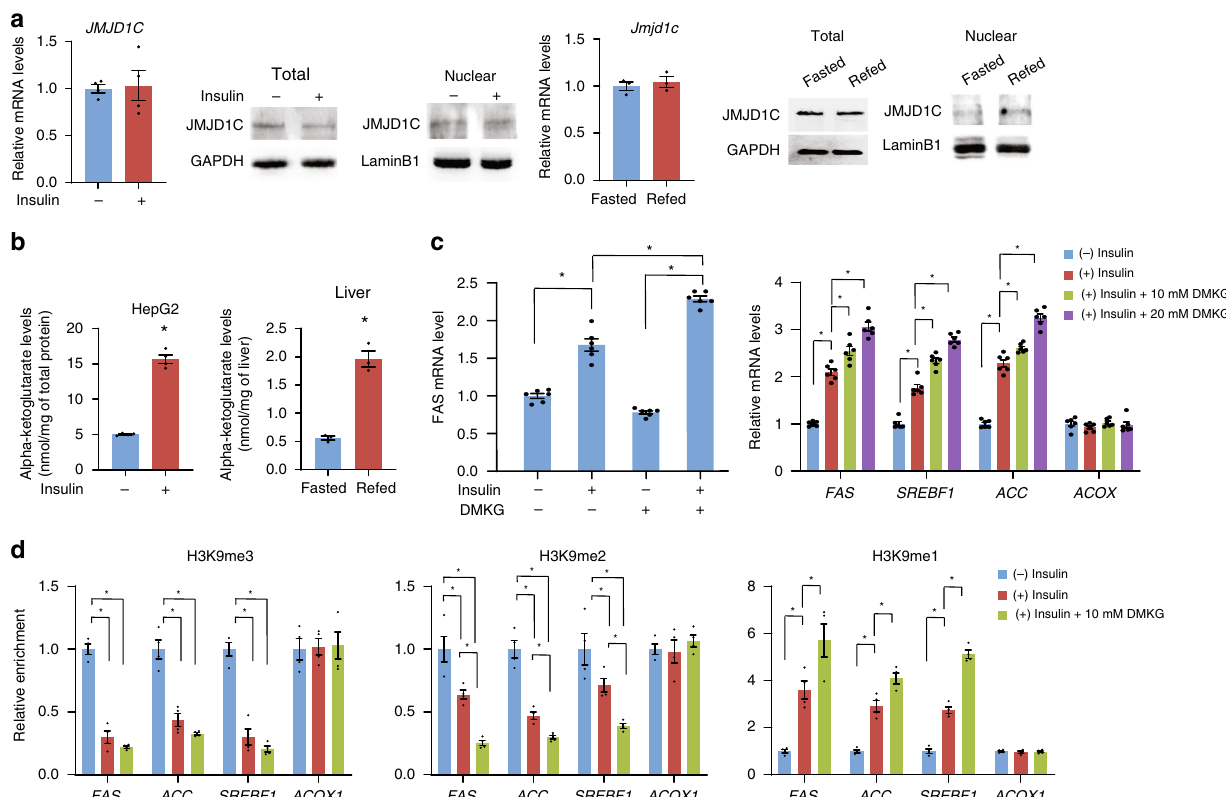
Fig. 6 α -KG level increases upon feeding/insulin treatment in liver for JMJD1C activity. a RT-qPCR for JMJD1C mRNA level and immunoblotting with anti- JMJD1C antibody for JMJD1C protein in whole-cell lysates and in nuclear extracts from HepG2 cells with or without insulin treatment (left three), n = 4 wells of cells per group. RT-qPCR for JMJD1C mRNA level and immunoblotting for JMJD1C protein in whole-tissue lysates and in nuclear extraction of livers from fasted or fed mice (right three), n = 3 per group. b intracellular levels of α - ketoglutarate levels in HepG2 cells with or without 100 nM insulin treatment for 30 min, n = 4 wells of cells per group (left) and in livers from fasted and refed mice, n = 3 per group (right). c RT-qPCR for FAS mRNA levels in HepG2 cells treated with or without 10 mM DMKG treatment for 8 h (left). RT-qPCR for mRNA levels of lipogenic genes with DMKG at indicated concentration (right), n = 6 wells of cells per group. d ChIP assay for enrichment of H3K9me3, H3K9me2, and H3K9me1 on lipogenic gene promoters in HepG2 cells with insulin and/or 10 mM DMKG treatment, n = 4 wells of cells per group. Data are expressed as means± SEM. * P < 0.05, determined by two-tailed t -test. Source data are provided as a source data fi